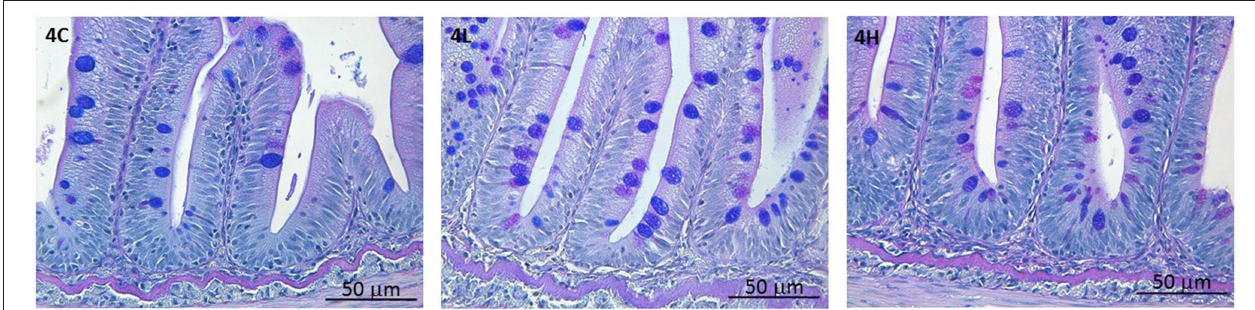
FIGURE 4 | Photomicrographs of the distal intestine of Atlantic salmon from the different groups. Representative images show the normal architecture of the intestine. Scale bar: 50 µ m. n = 6 tanks, 1 fish/tank.